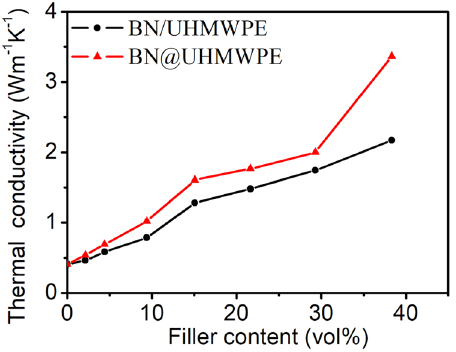
Figure 4: Thermal conductivity of BN/UHMWPE composites made by powder mixing and melt mixing as a function of BN